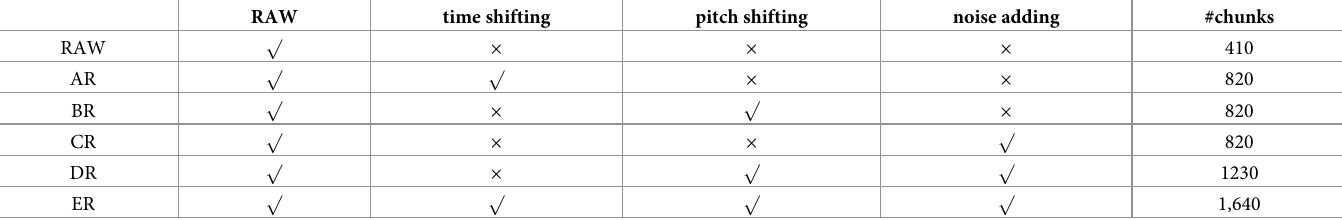
Table 3. Statistics of the six datasets.